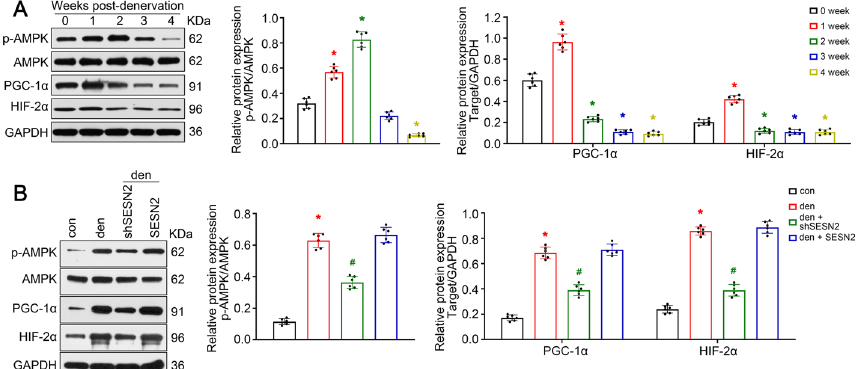
Fig. 6 SESN2 activated AMPK/PGC-1α signaling in denervated muscle. A Dynamic monitoring of AMPK/ PGC-1α signaling in GAS post-denervation. B Western blot analysis confirming the regulatory effect of SESN2 on the activity of AMPK/PGC-1α signaling. Data presented as mean 0 or sham operation group). # P < 0.05 versus denervation group. Den denervation, Con